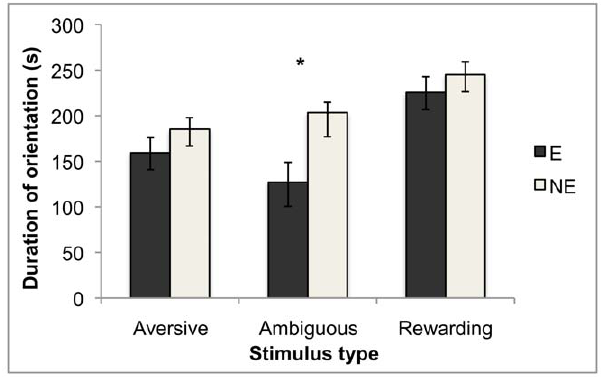
Figure 2. Duration oriented to the stimulus, split by housing treatment and stimulus type. Data are back-transformed least squares means, with error bars indicating confidence intervals. * indicates a significant difference at the group a =0.05 level (Tukey’s HSD). A version of this figure based on earlier statistical models was included in Meagher [81].